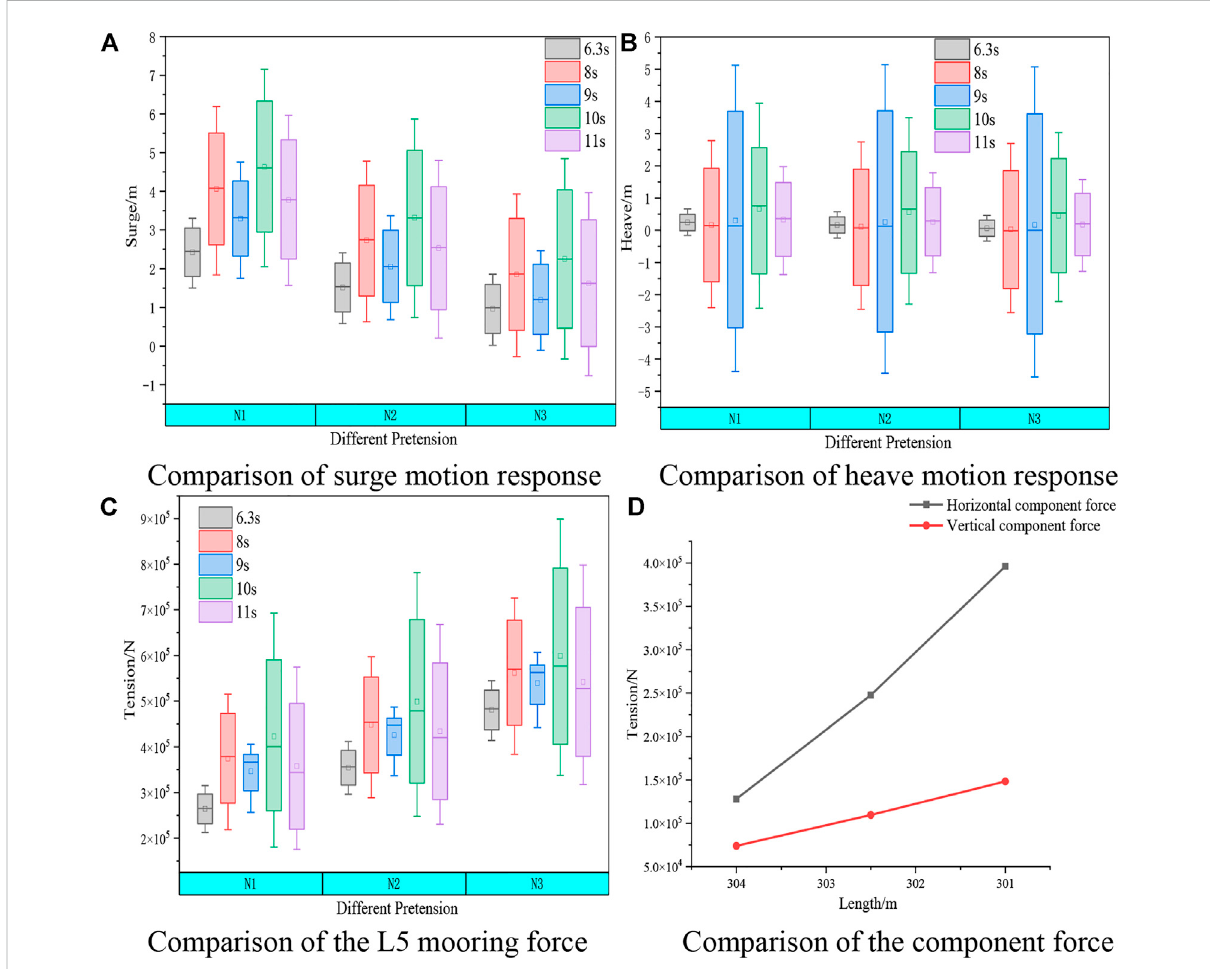
FIGURE 15 Comparison of the characteristics of the mooring system under different pretension. (A) . Comparison of surge motion response (B) . Comparison of heave motion response. (C) . Comparison of the L5 mooring force (D) . Comparison of the component